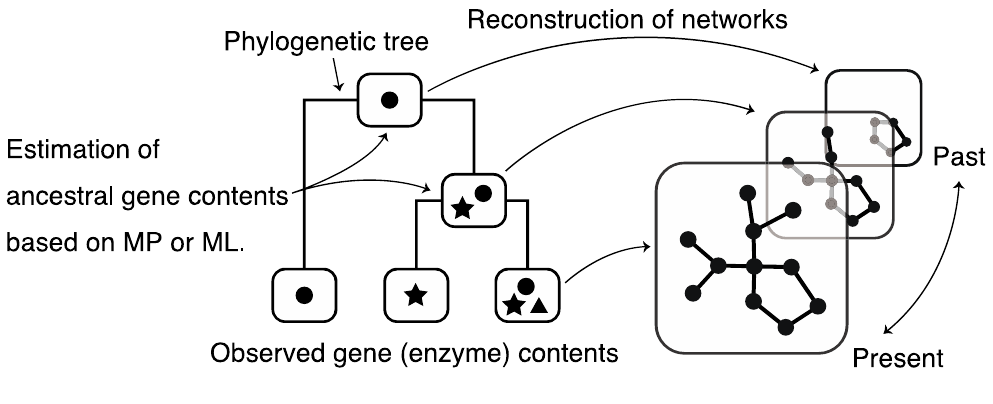
Figure 9. Schematic diagram of the reconstruction of ancestral metabolic networks. MP: maximum parsimony, ML: maximum